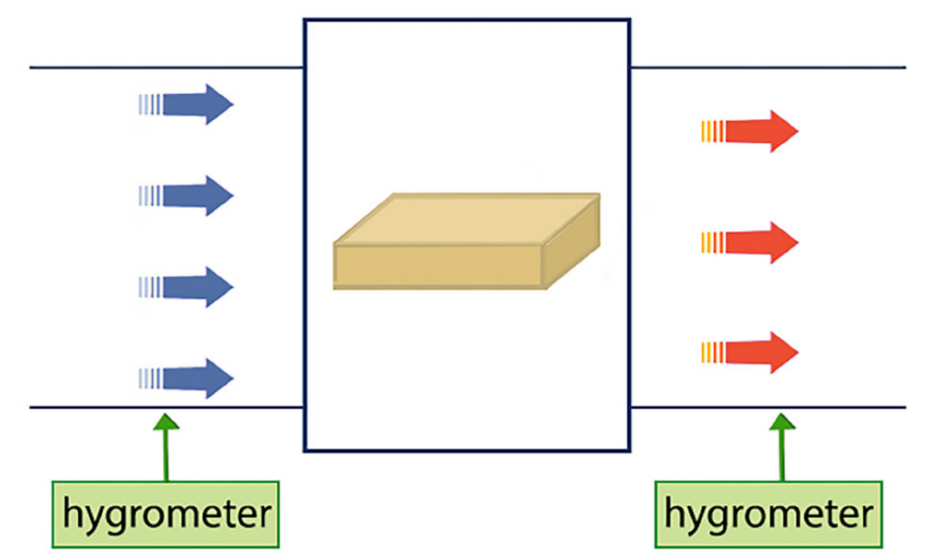
Figure 4. Moisture absorption rate detection principle of dried jujube